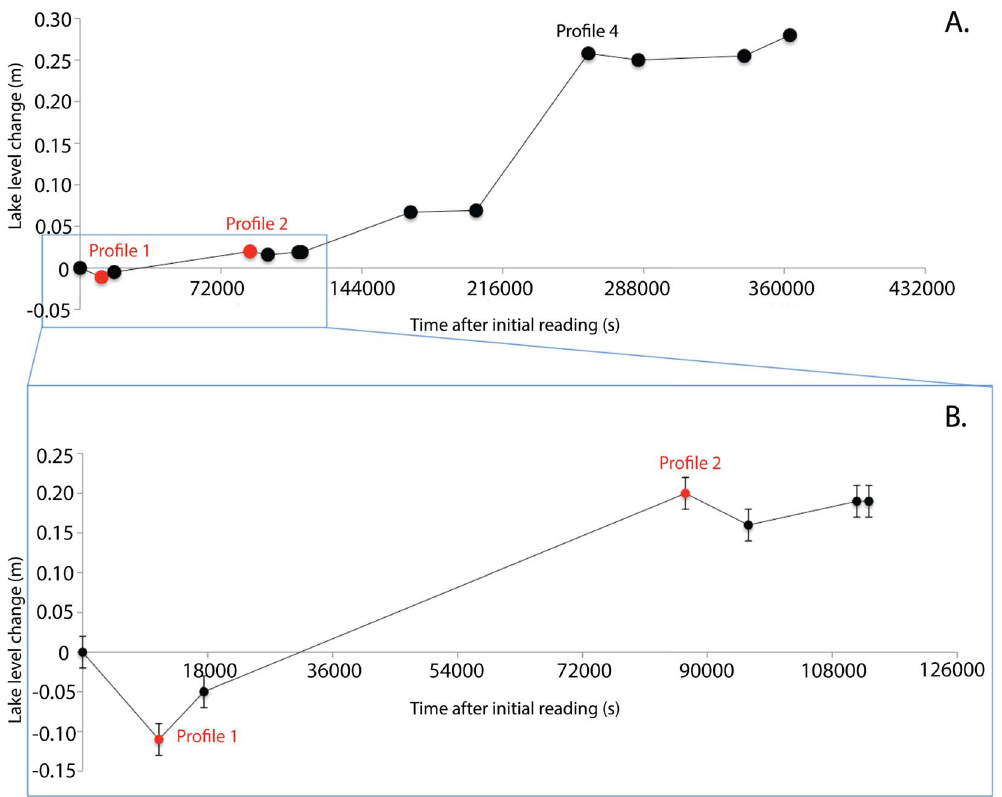
Figure 6. Lake Level Readings. Panel A: Recorded lake levels spanning the duration of sampling time, with several listed Profiles for reference. Values are reported in cm and on the time scale of seconds following initial lake level reading. Dates are listed above two of the plotted points. Panel B: Lake level readings between July 21–22. Red points correspond to values selected for estimation of lake tidal range. doi:10.1371/journal.pone.0090939.g006 means changes in water chemistry can cause calcite precipitation. While the decomposition of organic matter releases CO 2 and Increased photosynthesis, positively correlated to pH in the increases calcite solubility, the net precipitate accumulation may system, decreases the solubility of calcite, facilitating precipitation. be observable because of the microbial matrix created in the mat